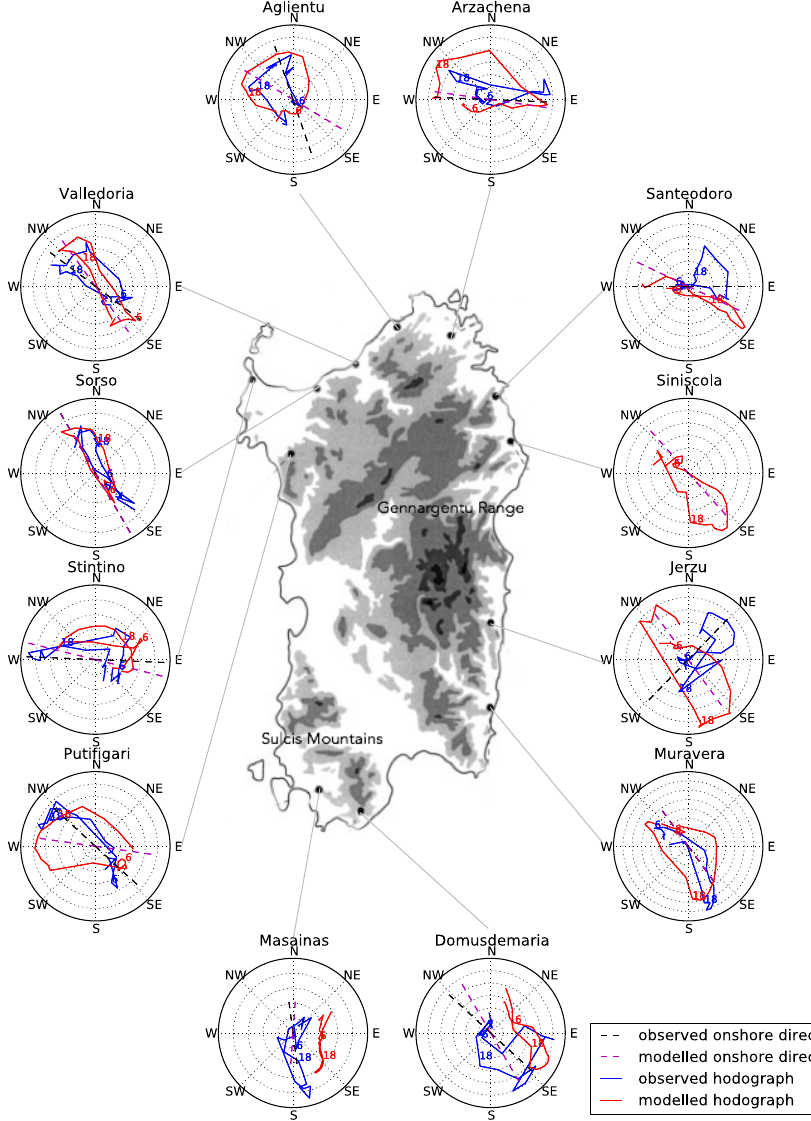
Figure 2. Modeled and observed wind hodographs at 10m over Sardinia on 21 June